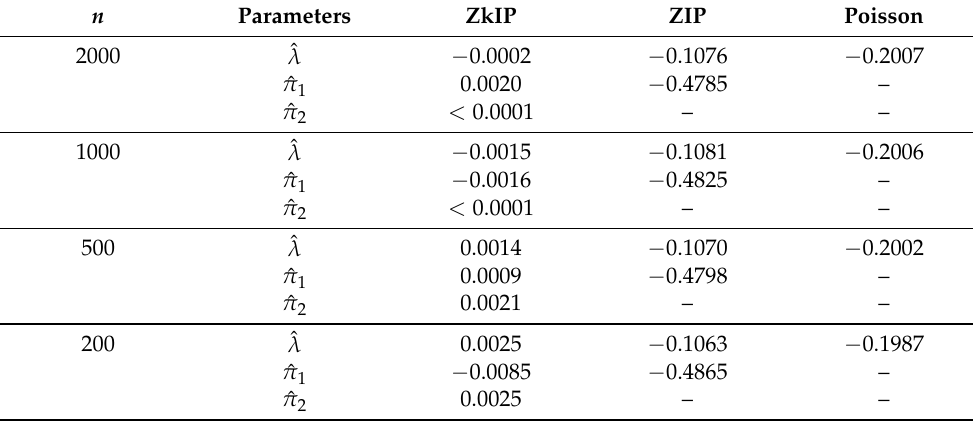
Table 4. Comparison of standardized bias (SBias) of the simulated data. True values λ = 2, π 1 = 0.2, π 2 = 0.4, and k =